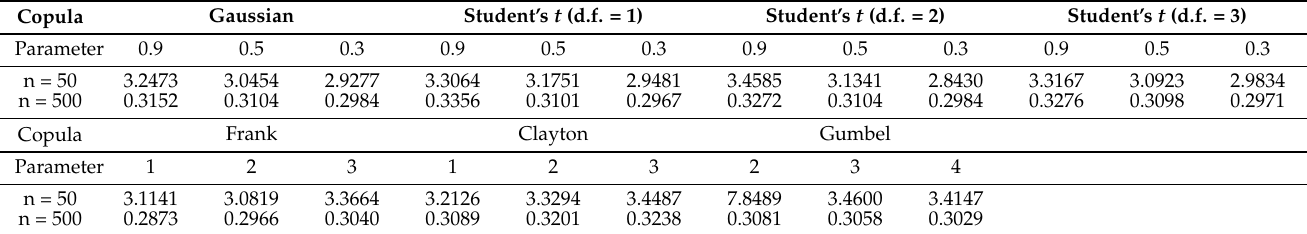
Table A1. Approximate MISE for the empirical copula × 1000 (d.f. indicates degree of freedom). Copula Gaussian Student’s t (d.f. =